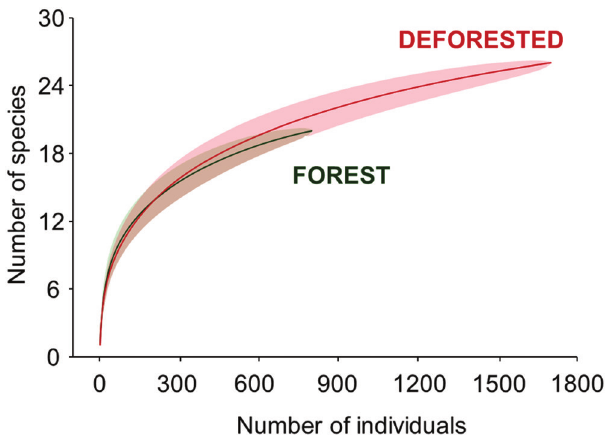
Fig. 3. Individual-based rarefaction curves calculated for fish assemblages collected in forest (n=9) and deforested (n=9) stream reaches in the Upper Xingu River Basin. Colored areas represent 95% confidence